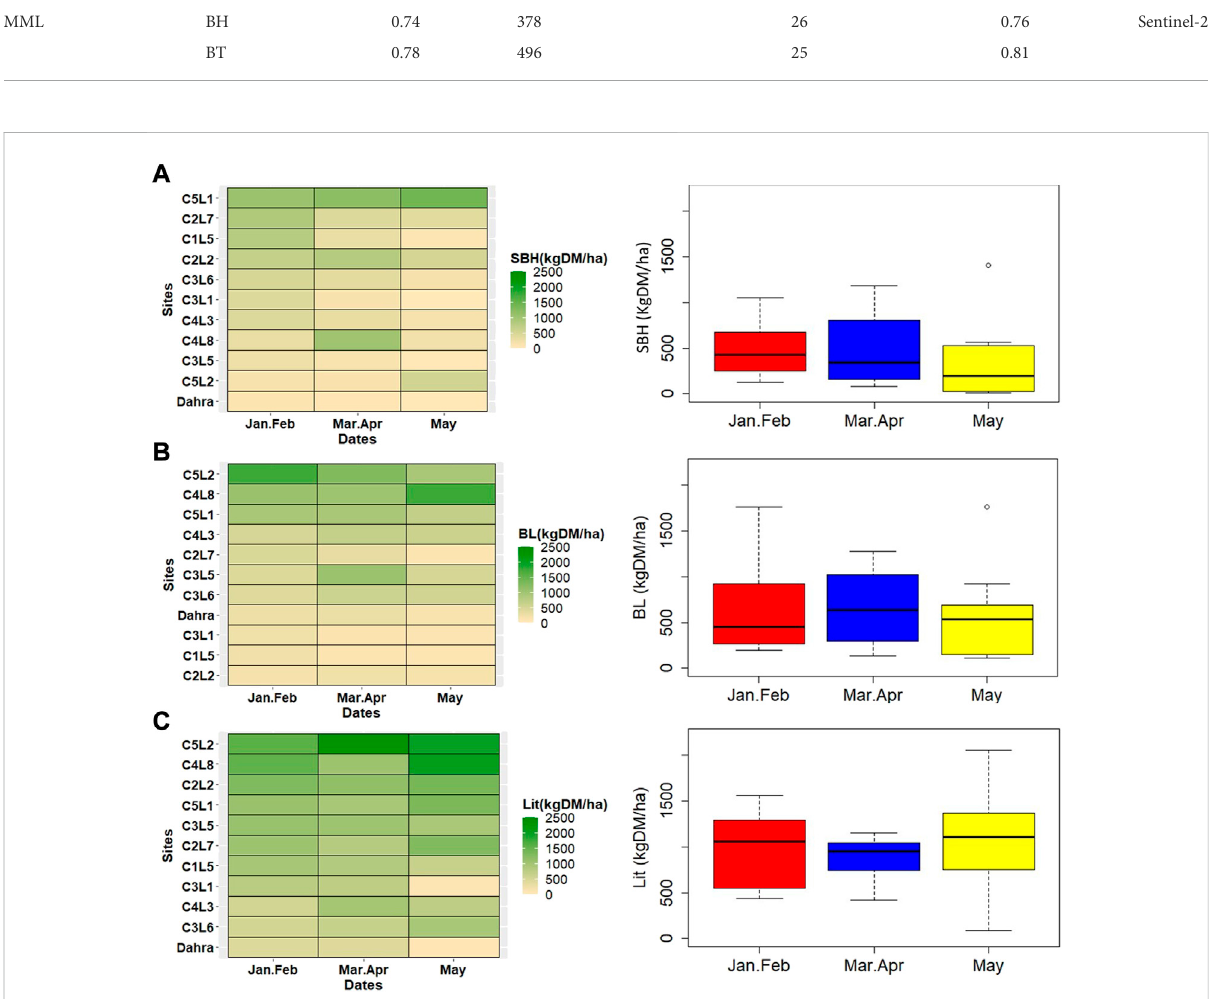
FIGURE 4 Variation of fi eld observed SBH (A) , BL (B) , and Lit (C) during the dry season. Jan.Feb = January – February, Mar.Apr = March – April. The values in the fi rst column of heatmaps were sorted in descending order from the top to